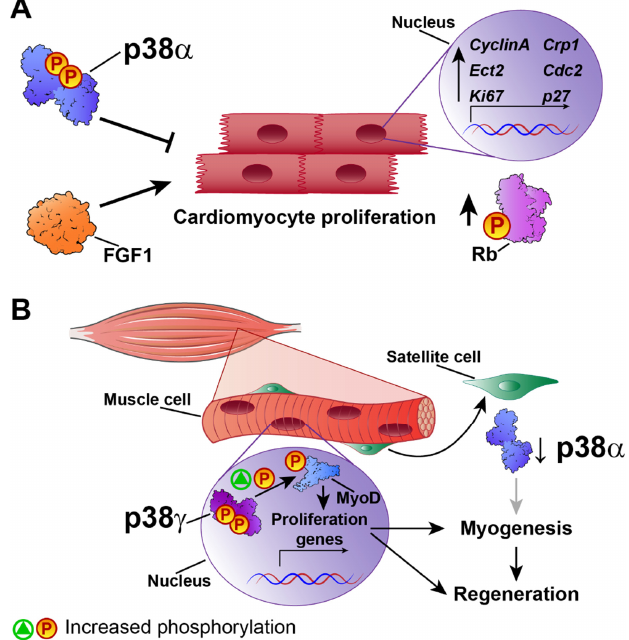
Figure 1. p38 in cardiovascular regeneration. (A) p38 α blocks cardiovascular regeneration by inhibiting the expression of genes involved in cardiomyocyte proliferation and regeneration, such as Ect2, Crp1, ki67, cdc2, cyclin A , and p27, and reducing Rb phosphorylation to block cell-cycle progression. FGF1 stimulation has the opposite effect. (B) p38 γ activates differentiation and myogenesis in satellite cells by phosphorylating MyoD and activating proliferation. p38 α prevents p38 γ activation in satellite cells, blocking regeneration. ↑ increase, ↓ decrease. The actions of p38 kinases in skeletal muscle regeneration have received much more attention than their roles in the heart. However, given the similarities between cardiac and skeletal muscle, the results of skeletal muscle studies can shed valuable light on the role of p38 in cardiac regeneration. Much research has focused on the potential role in adult myogenesis of p38 γ , which is highly expressed in skeletal muscle. p38 γ -deficient mice have a low muscle regeneration capacity after injury, with a reduced number of satellite cells that express myogenin prematurely and proliferate poorly. Mechanistically, p38 γ phosphorylates MyoD, enhancing its occupancy of the myogenin promoter and thereby suppressing its expression. p38 γ thus acts in opposition to p38 α , blocking premature differentiation by inducing a repressive MyoD transcriptional complex during satellite- cell–mediated muscle growth and muscle regeneration [44] (Figure 1B). MyoD activates proliferation- associated genes but not differentiation genes, whose regulatory regions are repressed by ZEB1. Macrophages present in the injured muscles of Zeb1-deficient mice have low phosphorylation levels of p38, and forced p38 activation alleviates muscle damage and improves muscle regeneration [45]. In a later study, Brien P et al. demonstrated that a lack of p38 α results in increased p38 γ activation [46], suggesting that p38 γ hyperactivation is involved in muscle regeneration. Aging is characterized by a general decline in metabolic activity and function, with a loss of both skeletal and cardiac muscle accompanied by marked functional and structural impairment. Skeletal muscle has an outstanding regenerative capacity provided by its resident satellite cells. These